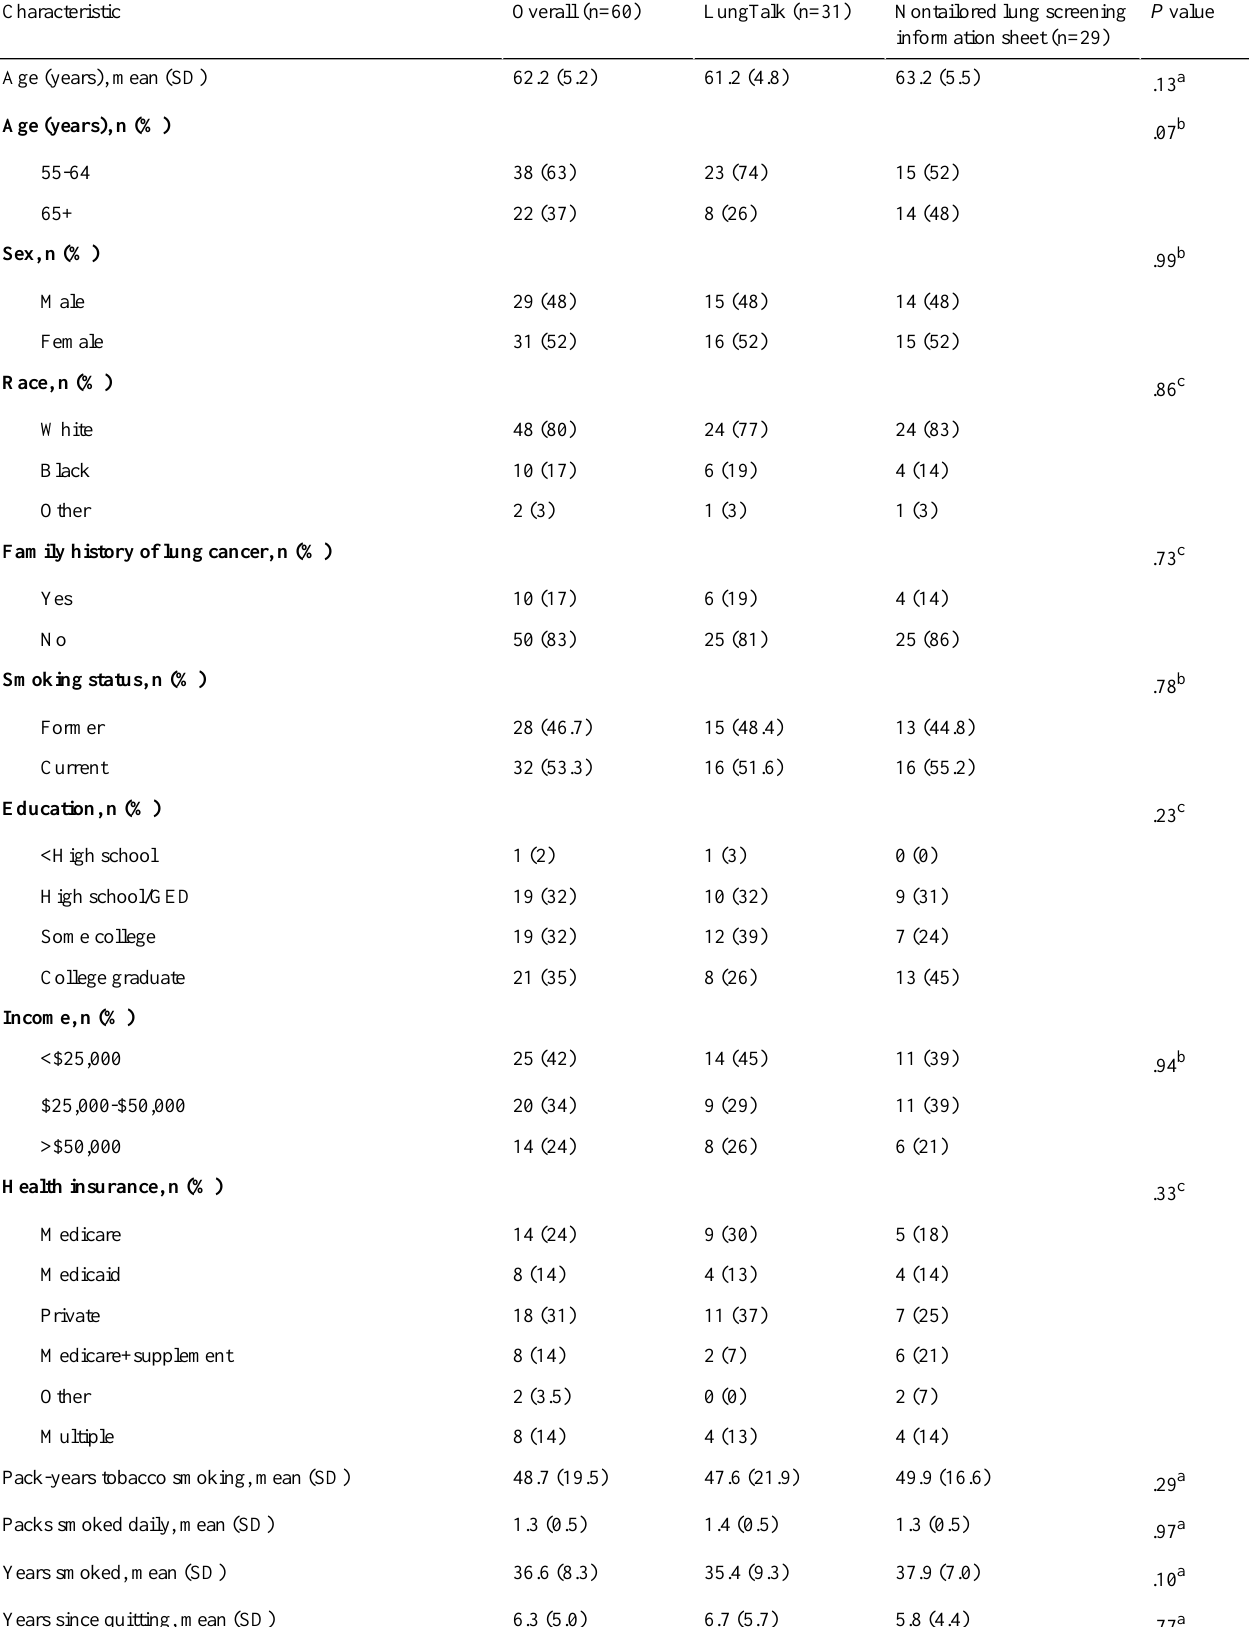
Table 1. Demographics and smoking characteristics at baseline.